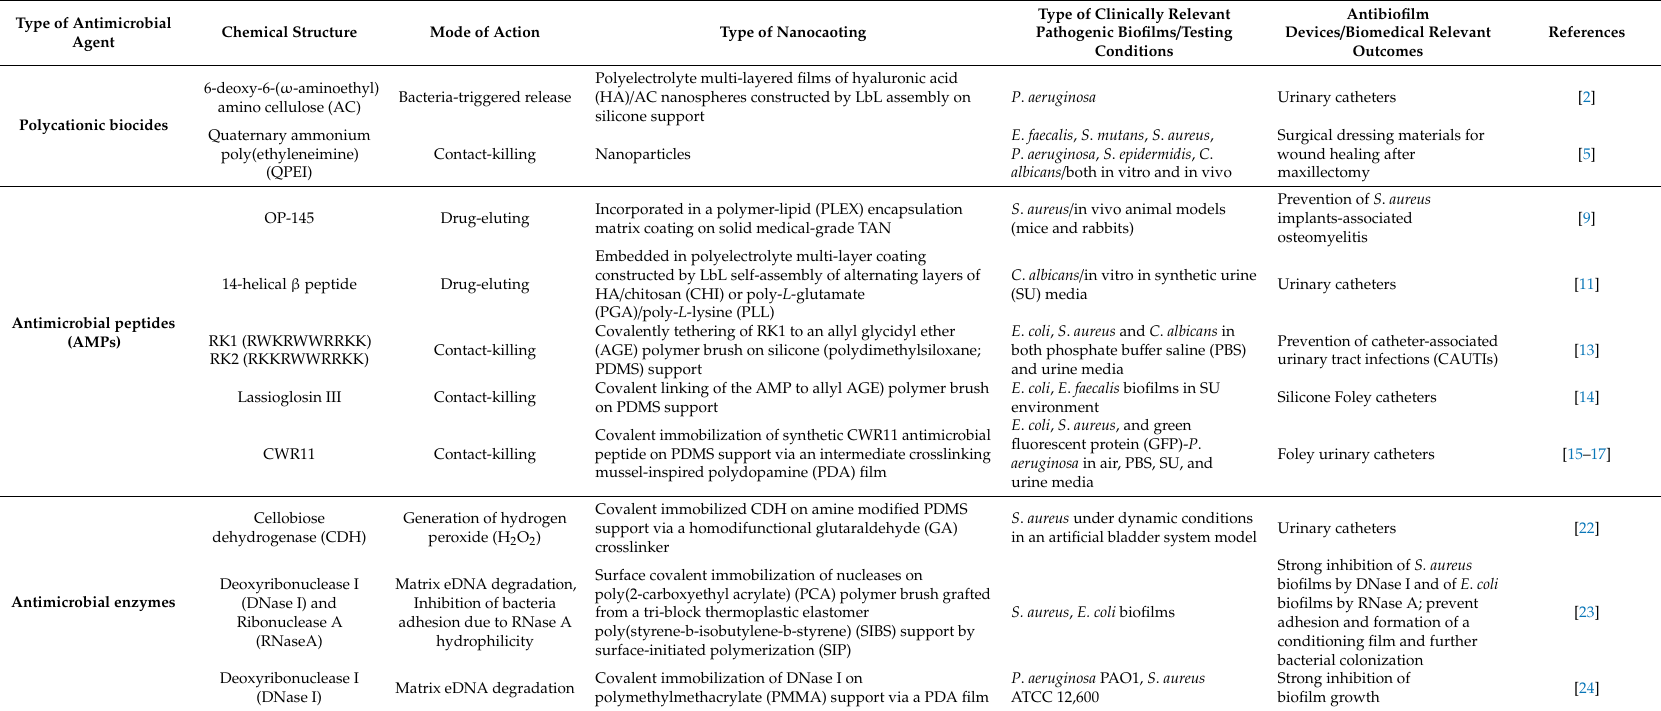
Table 1. Active antibiofilm strategies and the corresponding